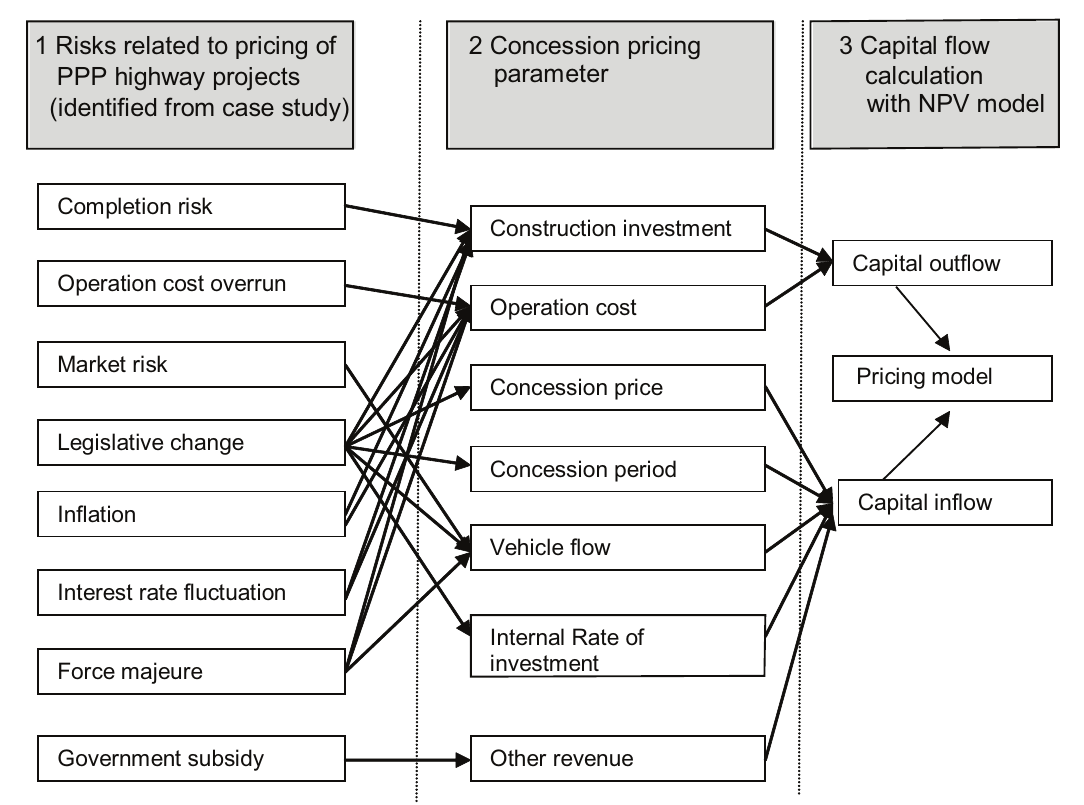
figure 4. The relationship between risk factors and cash flow (adopted from Yang, 2007)